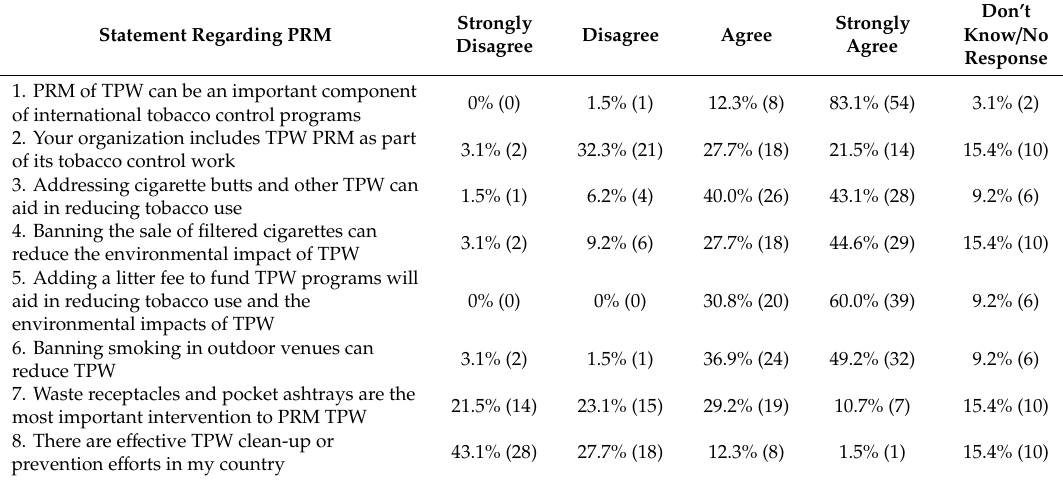
Table 2. Perception of prevention, reduction, and mitigation (PRM) strategies, members of Framework Convention Alliance, 2019 ( N =